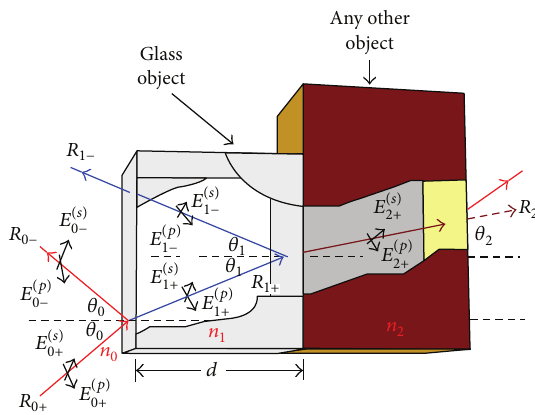
Figure 8: Reflection and transmission of ray from overlapped